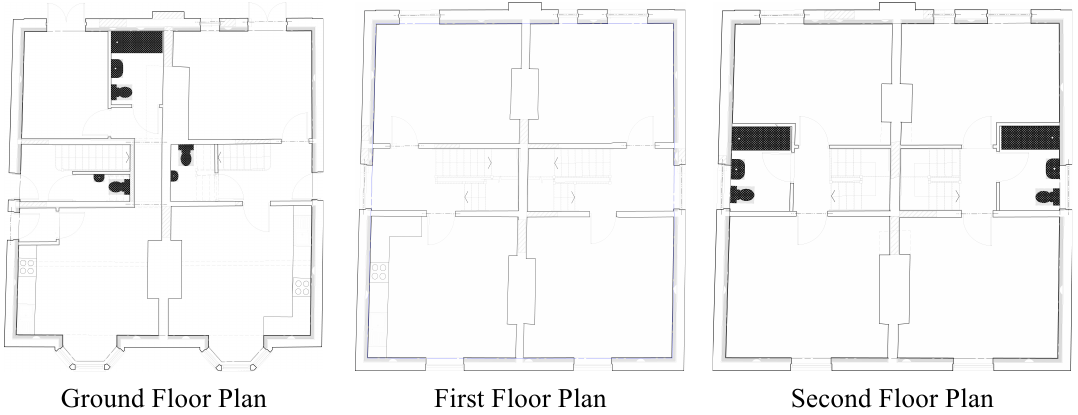
Figure 3. New floor plans after refurbishment (Reproduced based on the drawings by Allan Joyce Architects